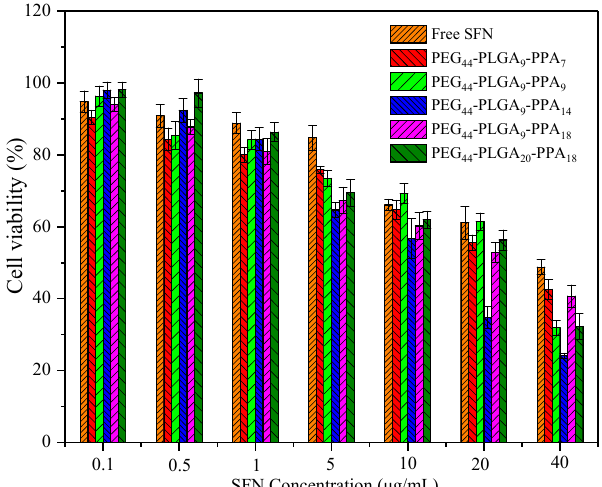
Figure 9. Cell viabilities of HeLa cells incubated with free SFN and SFN-loaded micelles for 24 h (n = 3, mean ± SD).